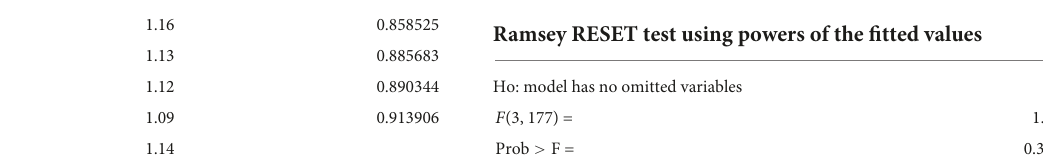
TABLE 8 Ramsey RESET